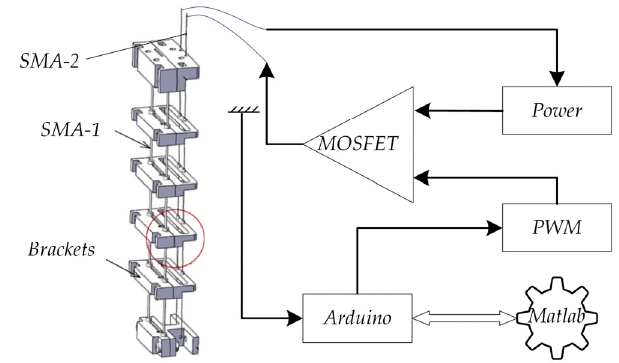
Figure 3. Soft robot control block